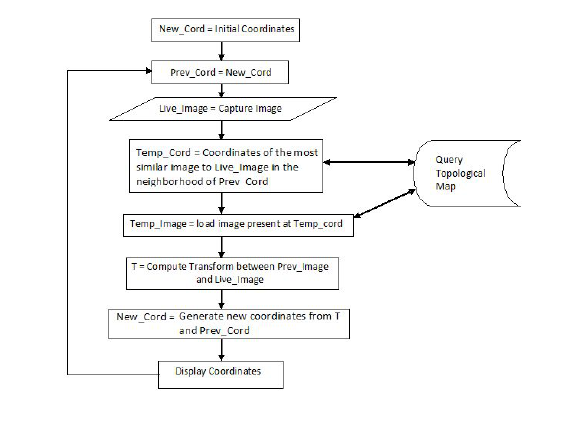
Figure 11: The different orientations of the robot. The arrowhead indicates the direction of the robot.